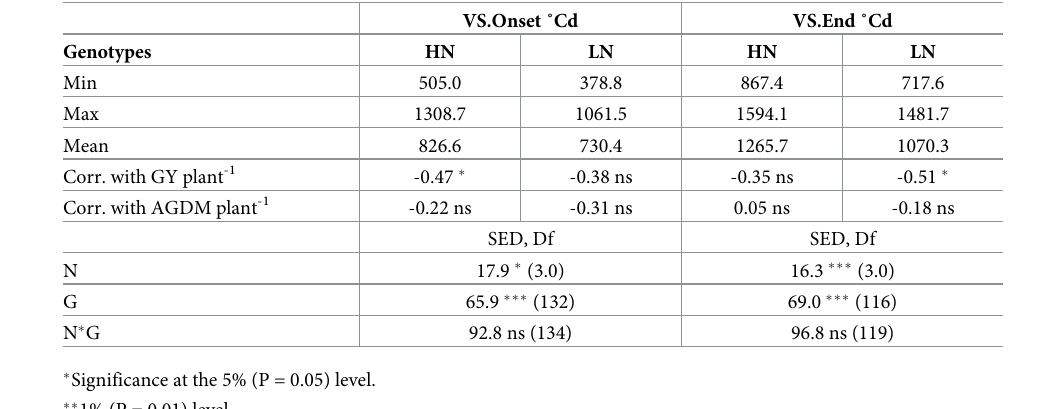
with negative effect. Under HN conditions, GY plant -1 was positively associated amongst genotypes with grains plant -1 (P < 0.001), grain N plant -1 (P < 0.001) and NUpE (P < 0.001) and negatively associated with anthesis date and VS.Onset. NUtE showed a positive association Table 3. Maximum, minimum and mean values for onset (VS.Onset) and end (VS.End) of flag-leaf senescence (thermal time post-anthesis (GS65), base temperature 0˚C) for 22 genotypes (18 amphidiploid lines and 4 parents) under HN and LN conditions (mean 2015 and 2016); significance levels for N, genotype (G) and N × G effects; and Pearson’s correlation coefficient for correlation with grain yield (GY) plant -1 and above-ground dry matter (AGDM) plant -1 .